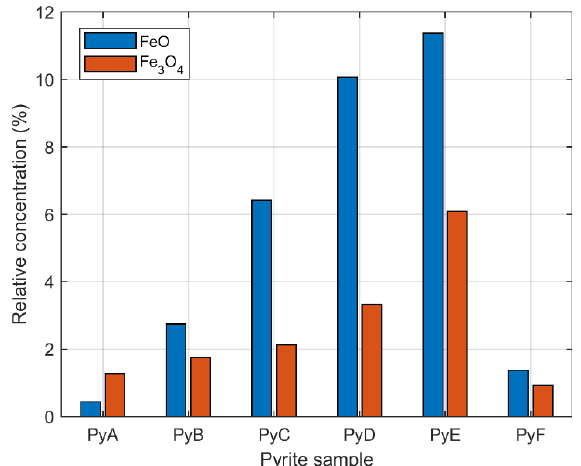
Figure 10. Relative concentrations (median values for each data set) of FeO and Fe 3 O 4 band emissions estimated from spectra of pyrite combustion. Obs. Sample particle sizes decrease from left to right.